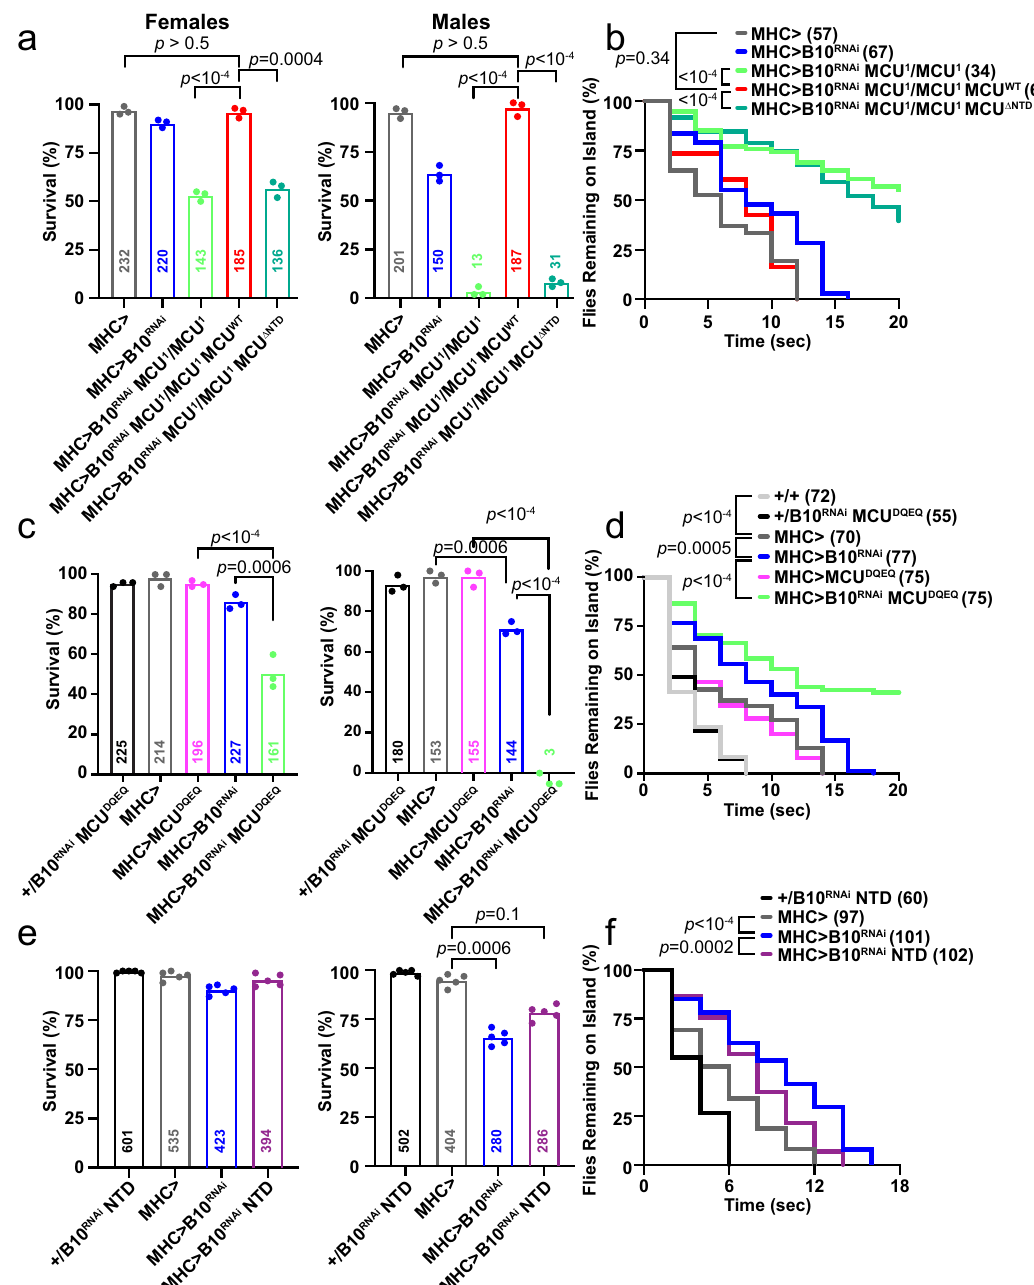
Fig. 6 Genetic interaction between MCU and Complex I in Drosophila . a , c , e Drosophila survival for the indicated genotypes and sex. b , d , f Quanti fi cation of dwell time in the island assay for indicated genotypes for female fl ies. a , b The muscle speci fi c MHC -GAL4 was used to drive expression of NDUFB10 RNAi , MCU WT , or MCU Δ NTD in wild-type or MCU 1 / MCU 1 mutant fl ies, as indicated. c , d As in ( a , b ), except the dominant-negative pore mutant MCU DQEQ was expressed with MHC- GAL4. e , f As in ( a , b ), except the isolated NTD fragment was expressed with MHC- GAL4. * p < 0.05, ** p < 0.01, *** p < 0.001. Statistics: ( a , c , e ) Fischer ’ s Exact Test with Bonferroni correction; ( b , d , f ) Log-rank (Mantel-Cox) test with Bonferroni correction. Source data are provided as a Source Data fi